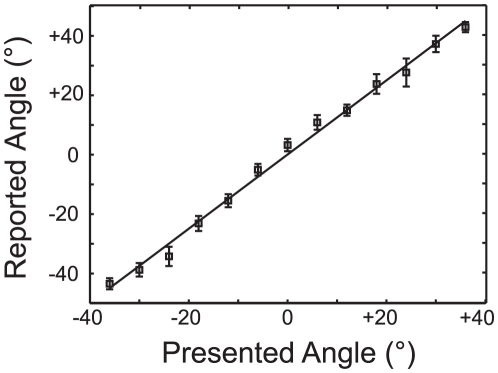
HRTFs precisely capture binaural auditory cues.Subjects indicated the perceived location of an HRTF filtered speech token (e.g. /aba/) at one of thirteen different locations via a pointing task. These indicated locations are plotted as a function of the intended (experimenter controlled) location. The data show a linear relationship between the Presented Angle and Reported Angle (1.25*X+0.176, R2 = 0.99). (mean ± SEM, N = 10).